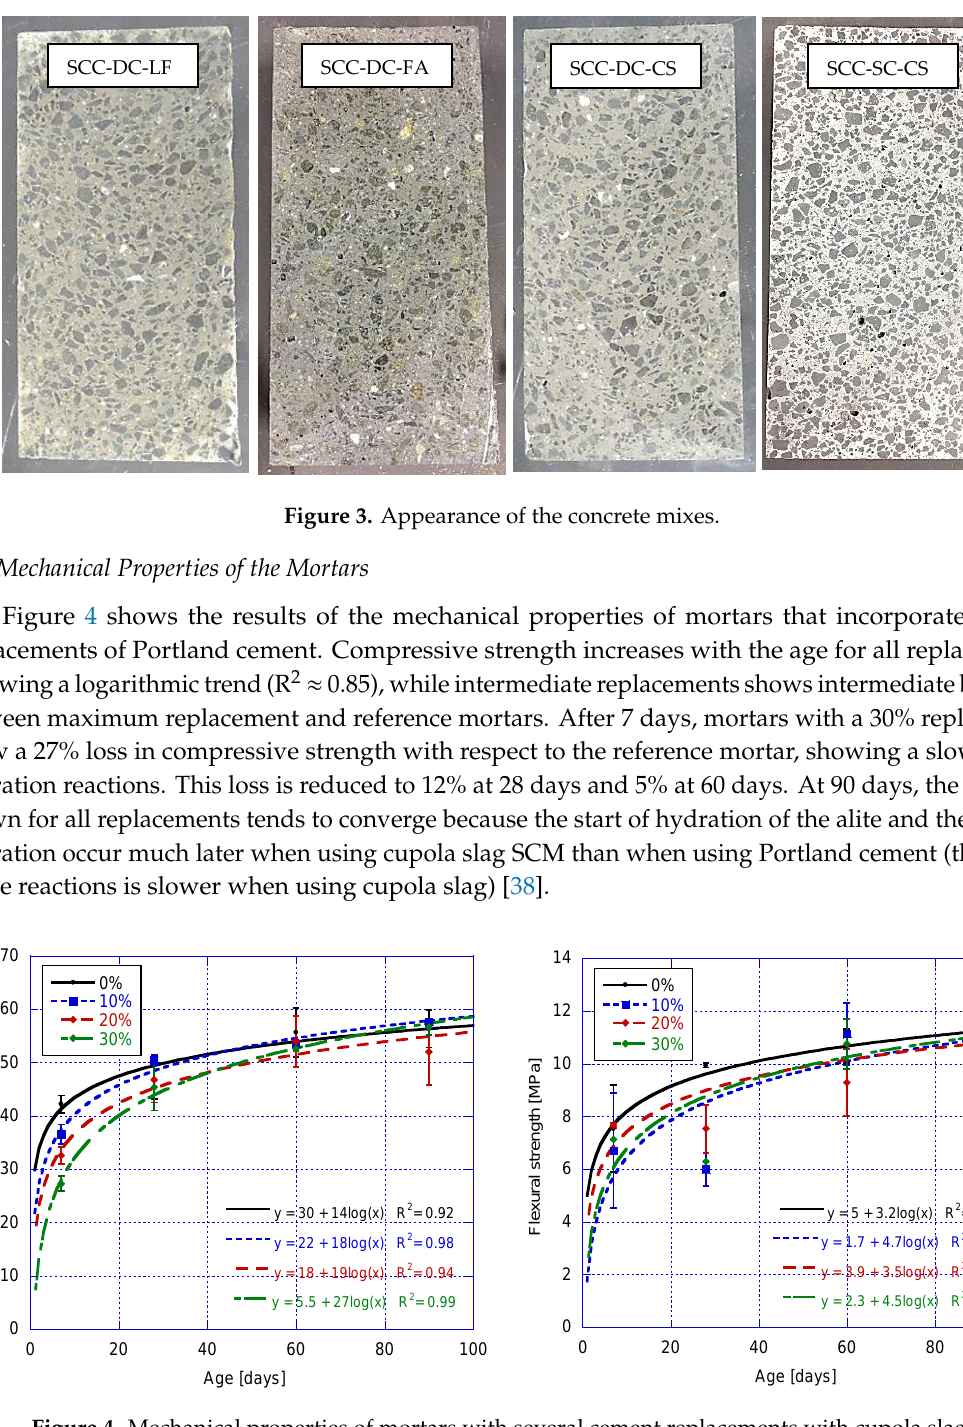
Figure 4. Mechanical properties of mortars with several cement replacements with cupola slag.